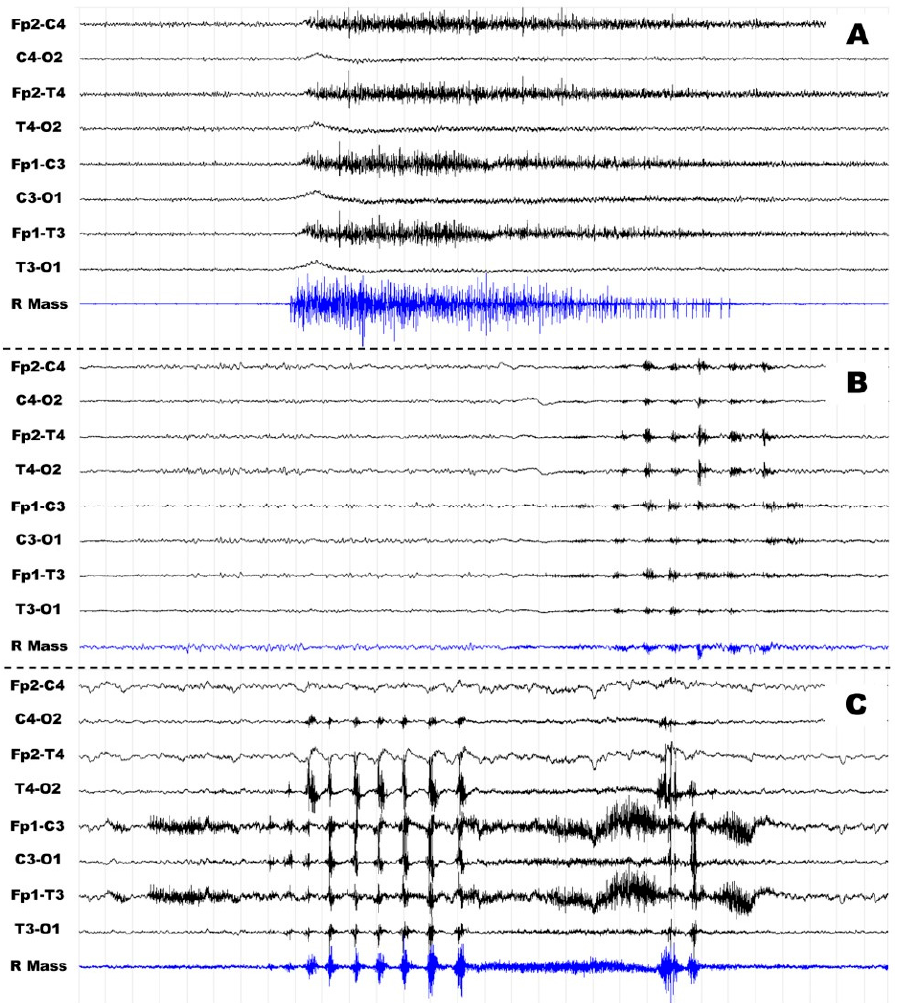
Figure 1. Examples of tonic, phasic, and mixed non-functional jaw muscle activity. Legend: example of tonic (( A ), patient #4), phasic (( B ), patient #7), and mixed (( C ), patient #1) non-functional muscle activity. On each page, only EEG (black) and right-masseter EMG (blue) traces are shown. Time window 30 s, sampling rate 512 Hz, filters 1–70 Hz, gain 20 microV/mm. Table 3. Results of the polygraphy and features of the non-functional jaw muscle